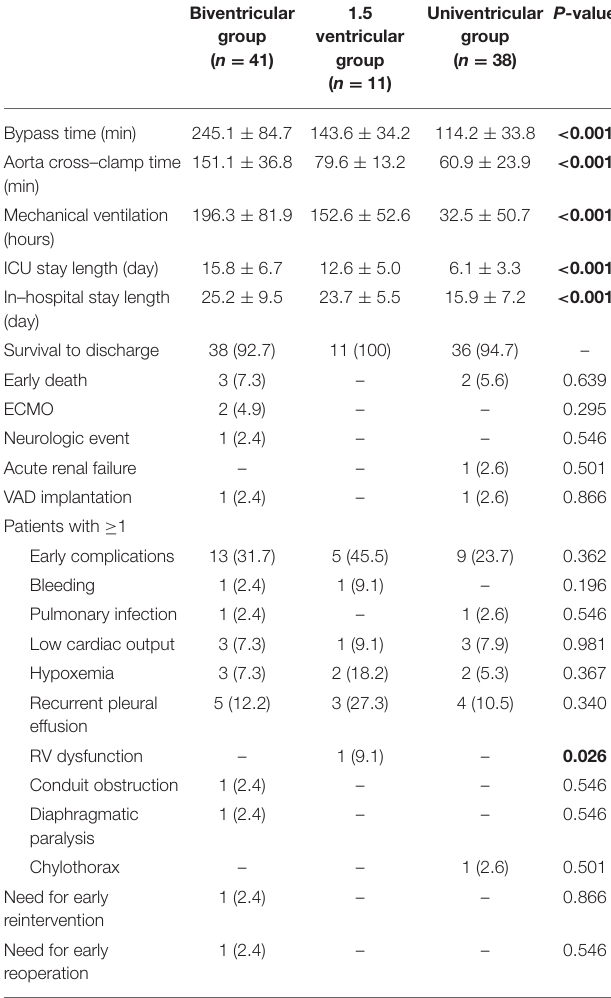
TABLE 2 | Early outcome stratified by different surgical